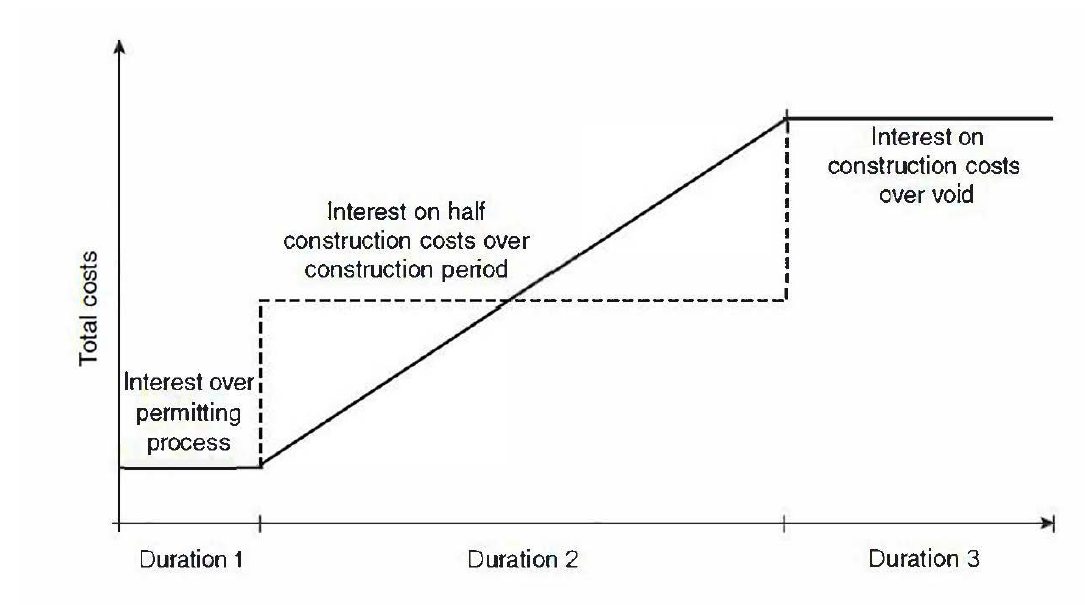
Figure 2: How interest is calculated (source: